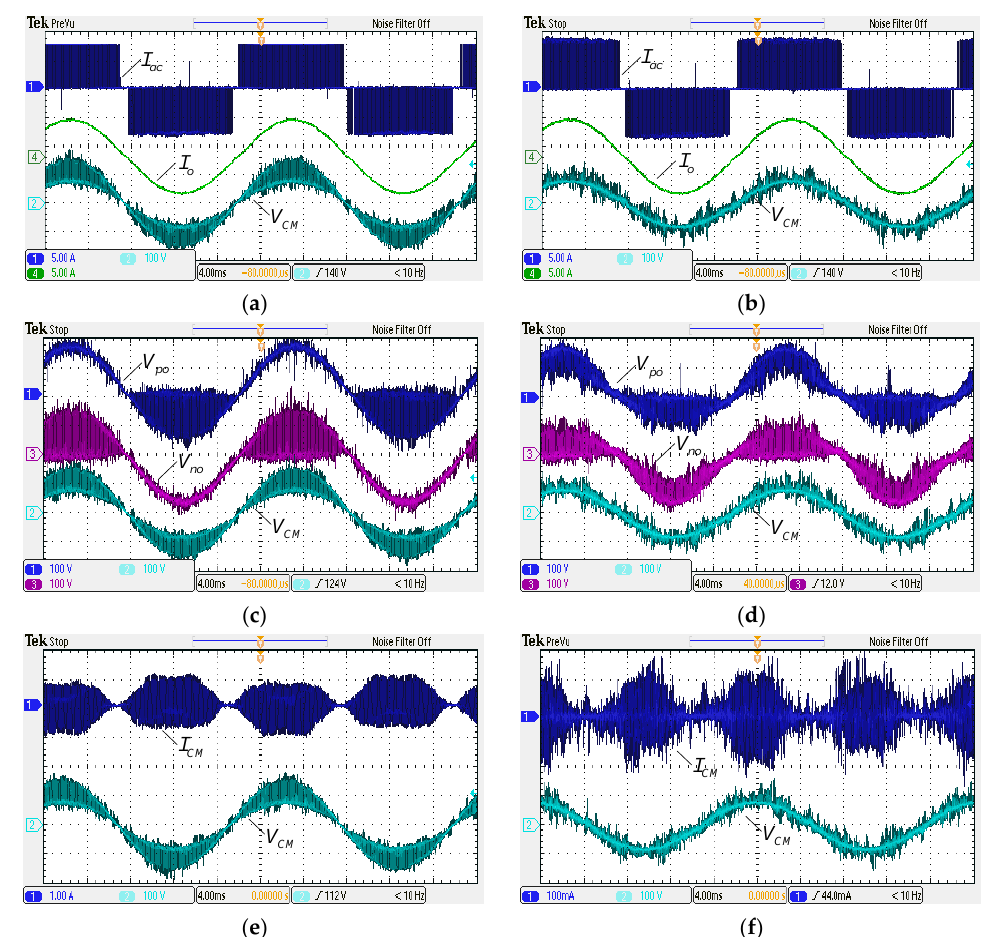
Figure 10a. On the other hand, the CMV is time-varying with high-frequency components as shown in Figure 10c. Consequently, the leakage current of CH4 inverter is as high as 1.2 A, which fails to comply with the VDE-0126-1-1 standard, as shown in Figure 10e. On the right, it is the experimental waveforms of proposed inverter that correspond to the CH4. It can be observed that the high- frequency components of CMV are significantly suppressed, compared with the experimental results of the CH4 inverter. Consequently, the leakage current of the proposed CH5 inverter is much smaller than that of CH4 inverter. The amplitude of the leakage current is well below 300 mA, which meets the VDE-0126-1-1 standard.